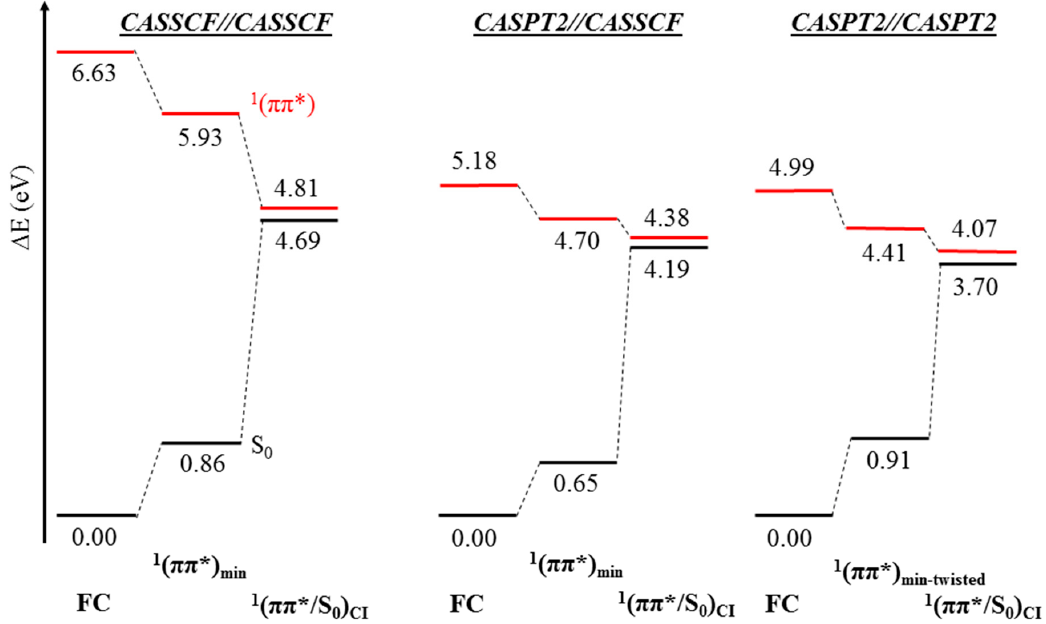
Figure 4. CASSCF//CASSCF, CASPT2//CASSCF, and CASPT2//CASPT2 energy diagrams of the key structures predicted to partake in the deactivation along the 1 ( ππ *) state. Results obtained from excited-state geometry optimizations and MEPs with the (10,8) active space and the 6-31G* basis set. Some differences are encountered for the geometry of the 1 (n O π *) minimum. Whereas CASSCF predicts a partially twisted structure, both CASPT2 and MS-CASPT2 yield completely planar geometries more similar to the 1 (n O π */ ππ *) CI crossing mediating the 1 (n O π *) non-adiabatic population (see SI). The structural similarities featured between the 1 (n O π *) minimum and 1 (n O π */ ππ *) CI , as well as their energetic proximity, according to the CASPT2//CASSCF and CASPT2//CASPT2 protocols, may promote a re-crossing back to the 1 ( ππ *) manifold [25] that may explain the reduced 1 (n O π *) yield registered experimentally [55]. This would drastically reduce the role of the 1 (n O π *) state in the photo-process, in contrast to what has been reported in MRCIS and CASSCF non-diabatic molecular dynamics studies [26,93,95], where a vast fraction of the excited